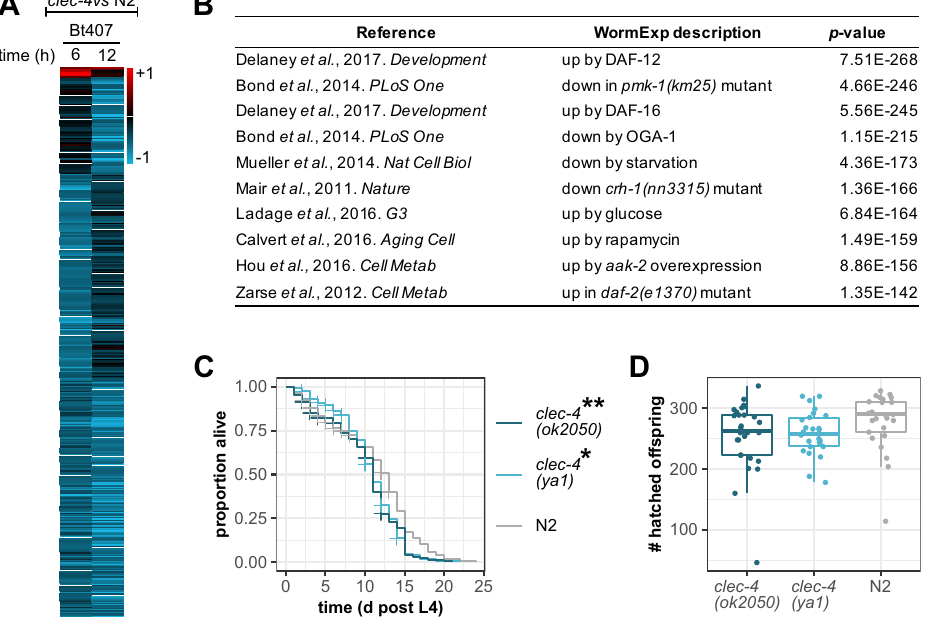
Fig 4. Transcriptional and WormExp EASE analysis and life history traits of clec-4(ok2050) and clec-4(ya1) . (A) Heatmap representing all significant differentially expressed (DE) genes 6 h and 12 h after exposure to non-pathogenic Bt407, comparing clec-4(ok2050) with wildtype N2. (B) Overview of enrichment of WormExp gene sets [70–77], inferred from Expression Analysis Systematic Explorer (EASE) analysis on differentially expressed genes 6 h and 12 h after exposure to non-pathogenic Bt407, comparing clec-4(ok2050) with wildtype N2. p -values are Benjamini- Hochberg corrected. (Also see S5A and S5B Table). (C) Lifespan analysis of clec-4(ok2050) and clec-4(ya1) mutants and N2 wildtype animals under standard conditions. Lifespan analyses led to inconclusive results as lifespan curves of clec- 4 mutants crossed the curve of N2, n = 5, data are representative of three independent experiments (also see S4A and S4B Fig). � p < 0.05, ��� p < 0.001, according to Kaplan-Meier analysis [55] and log-rank test [56]. Horizontal ticks represent censored data (missing worms). (D) Lifetime brood size of clec-4(ok2050) and clec-4(ya1) mutants and N2 wildtype animals. Shown are pooled data, n = 30 combined from three independent experiments. No significant differences between worm strains as determined by Wilcoxon rank sum test. Also see S4C and S4D Fig, and S2C, S3G and S3H